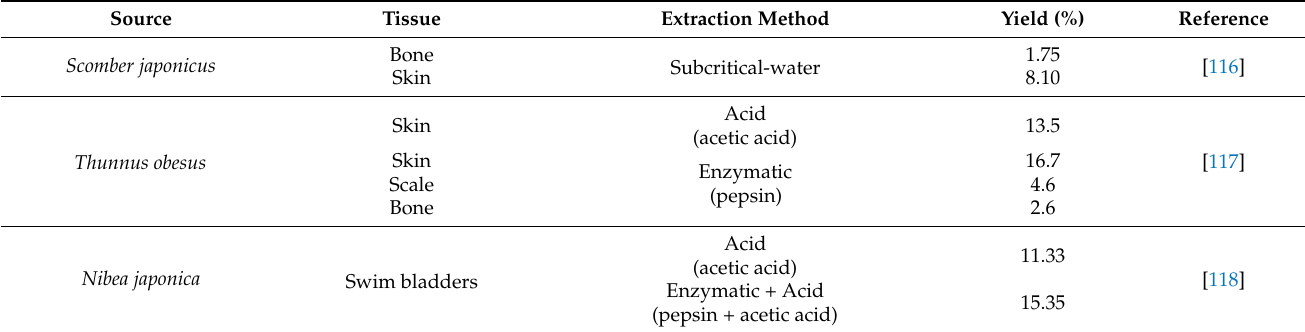
Table 2. Recent studies on various techniques for fish collagen